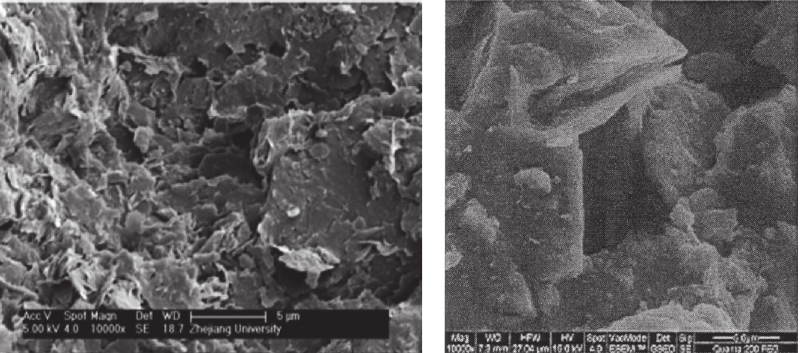
Figure 4: SEM results of clay particles.